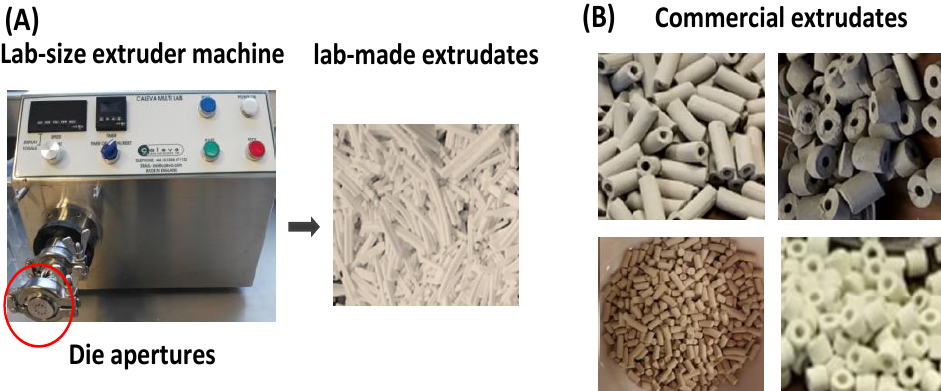
Figure 1. ( A ) Schematic illustration of zeolite shaping using extrusion technique, ( B ) Commercial extrudates with different geometrical structures.